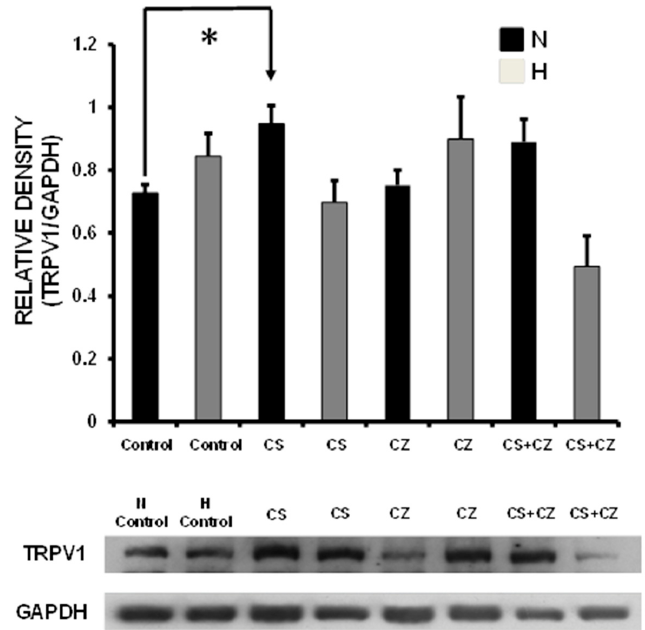
Figure 6. Expression of TRPV1 in the cardiac tissue from normotensive (N) and hypertensive (H) rats, in the absence and presence of capsaicin (CS), capsazepine (CZ), and capsazepine + capsaicin (CZ + CS). ( n = 3–4 rats / group). By Duncan’s post hoc test. Data are presented as means ± SEM. (* p < 0.05